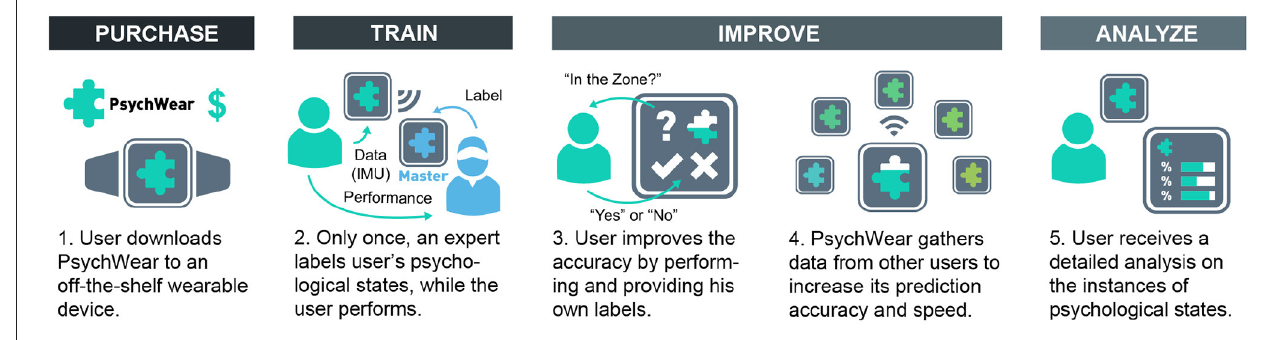
FIGURE 3 | Contextualization of the approach: PsychWear’s usage scenario and